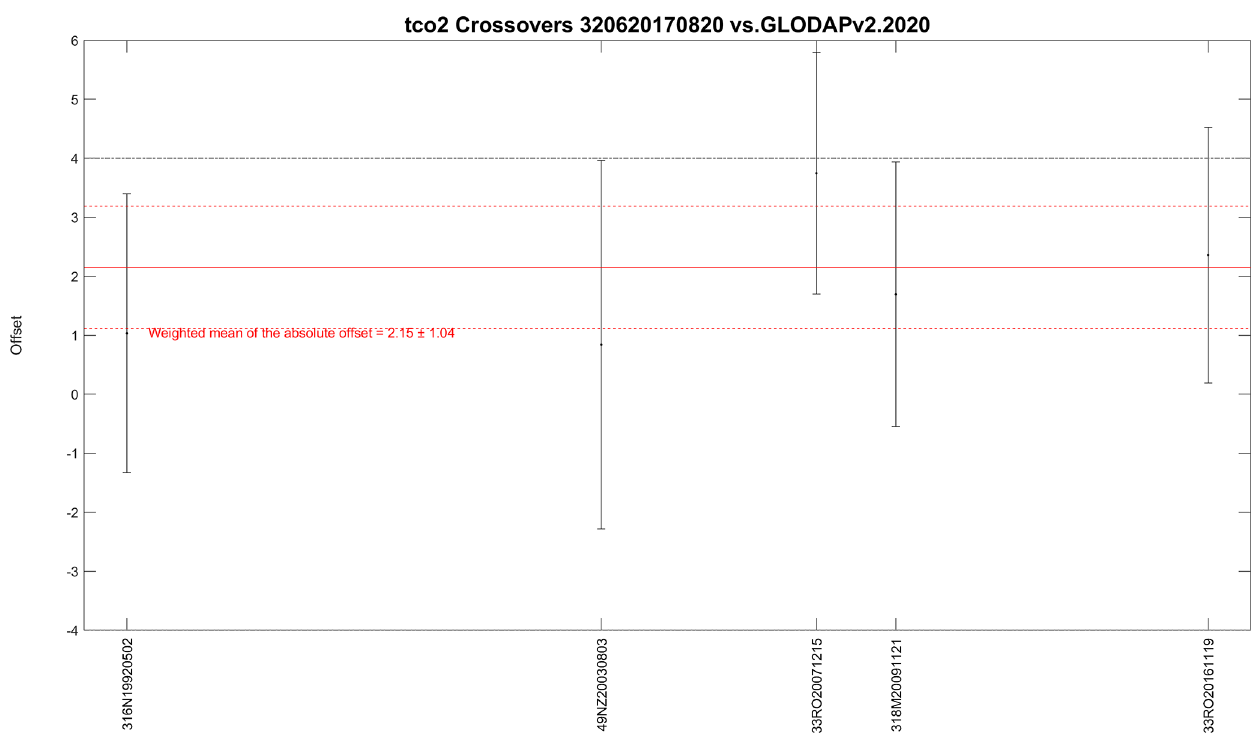
Figure 4. Example summary figure, for TCO 2 crossovers for 320620170820 versus the cruises in GLODAPv2.2020 (with cruise EX- POCODE listed on the x axis sorted according to year the cruise was conducted). The black dots and vertical error bars show the weighted mean offset and standard deviation for each crossover (in µmolkg − 1 ). The weighted mean and standard deviation of all these offsets are shown in the red lines and are 2.15 ± 1.04µmolkg − 1 . The dashed black line is the reference line for a + 4µmolkg − 1 offset (the correspond- ing line for – 4µmolkg − 1 offset is right on top of the x axis and not